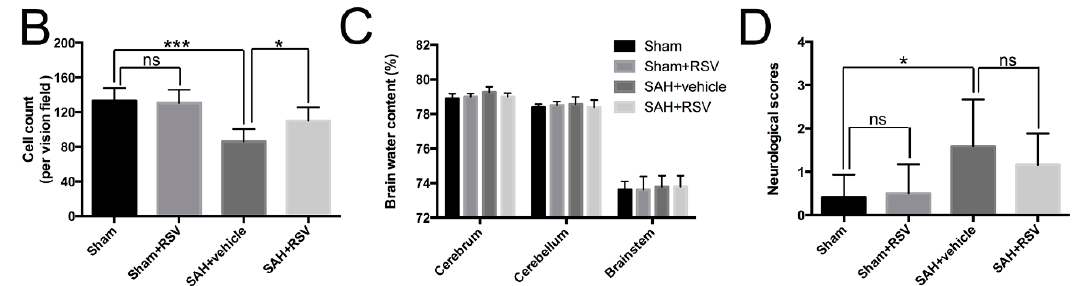
Figure 5. Effects of resveratrol (RSV) on neuronal survival, brain edema, and neurological function at 72 h post subarachnoid hemorrhage (SAH). ( A , B ) RSV treatment significantly increased the proportion of survived neurons compared with the SAH + vehicle group; Higher magnification of Nissl staining was shown in the red box for all groups; ( C , D ) RSV failed to alleviate brain edema and the impairment of neurological behavior compared with SAH + vehicle group at 72 h post SAH. Bars represent the mean ± SD. *** p < 0.001, * p < 0.05, and ns means non-significant. Scale Bars = 50 μ m.